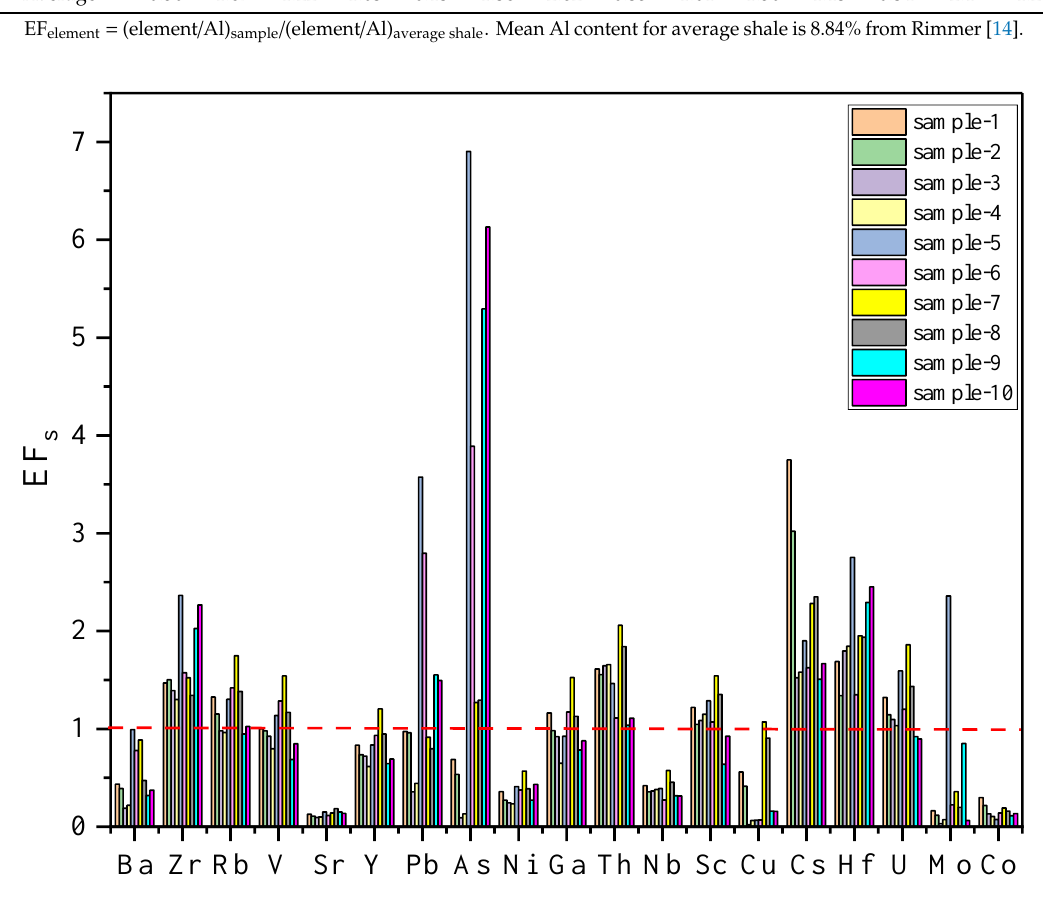
Figure 7. EFs of selected trace elements in the Semanggol black shale. A horizontal red dashed line (EF = 1) indicates an element enrichment or depletion of these TEs.